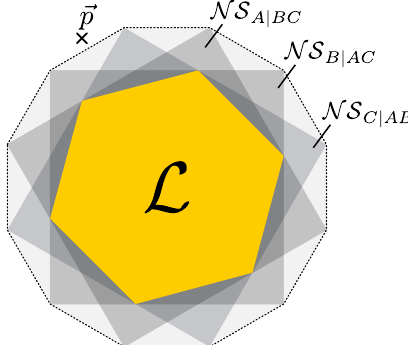
Figure 2: A vector ⃗ p corresponding to a behaviour { p ( abc | x yz ) } is non-signalling bilocal if it is inside the convex hull of all bipartite local polytopes (dashed line), where distant parties respect the non-signalling constraints. Behaviours which are not non-signalling bilocal are referred here as NS genuine tripartite Bell